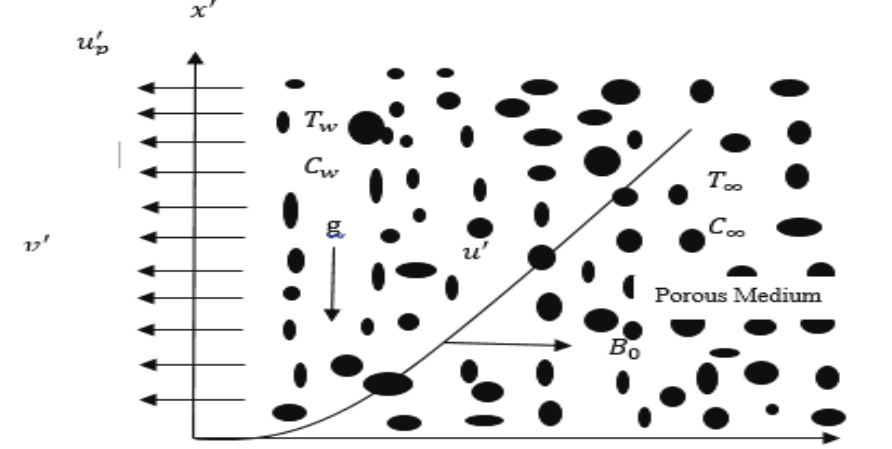
Figure 1: Sketch of the flow